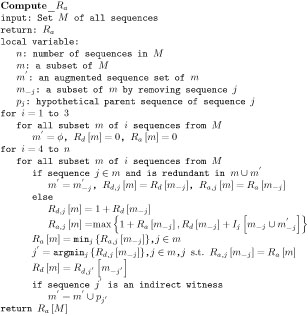
An algorithm for computing Ra.